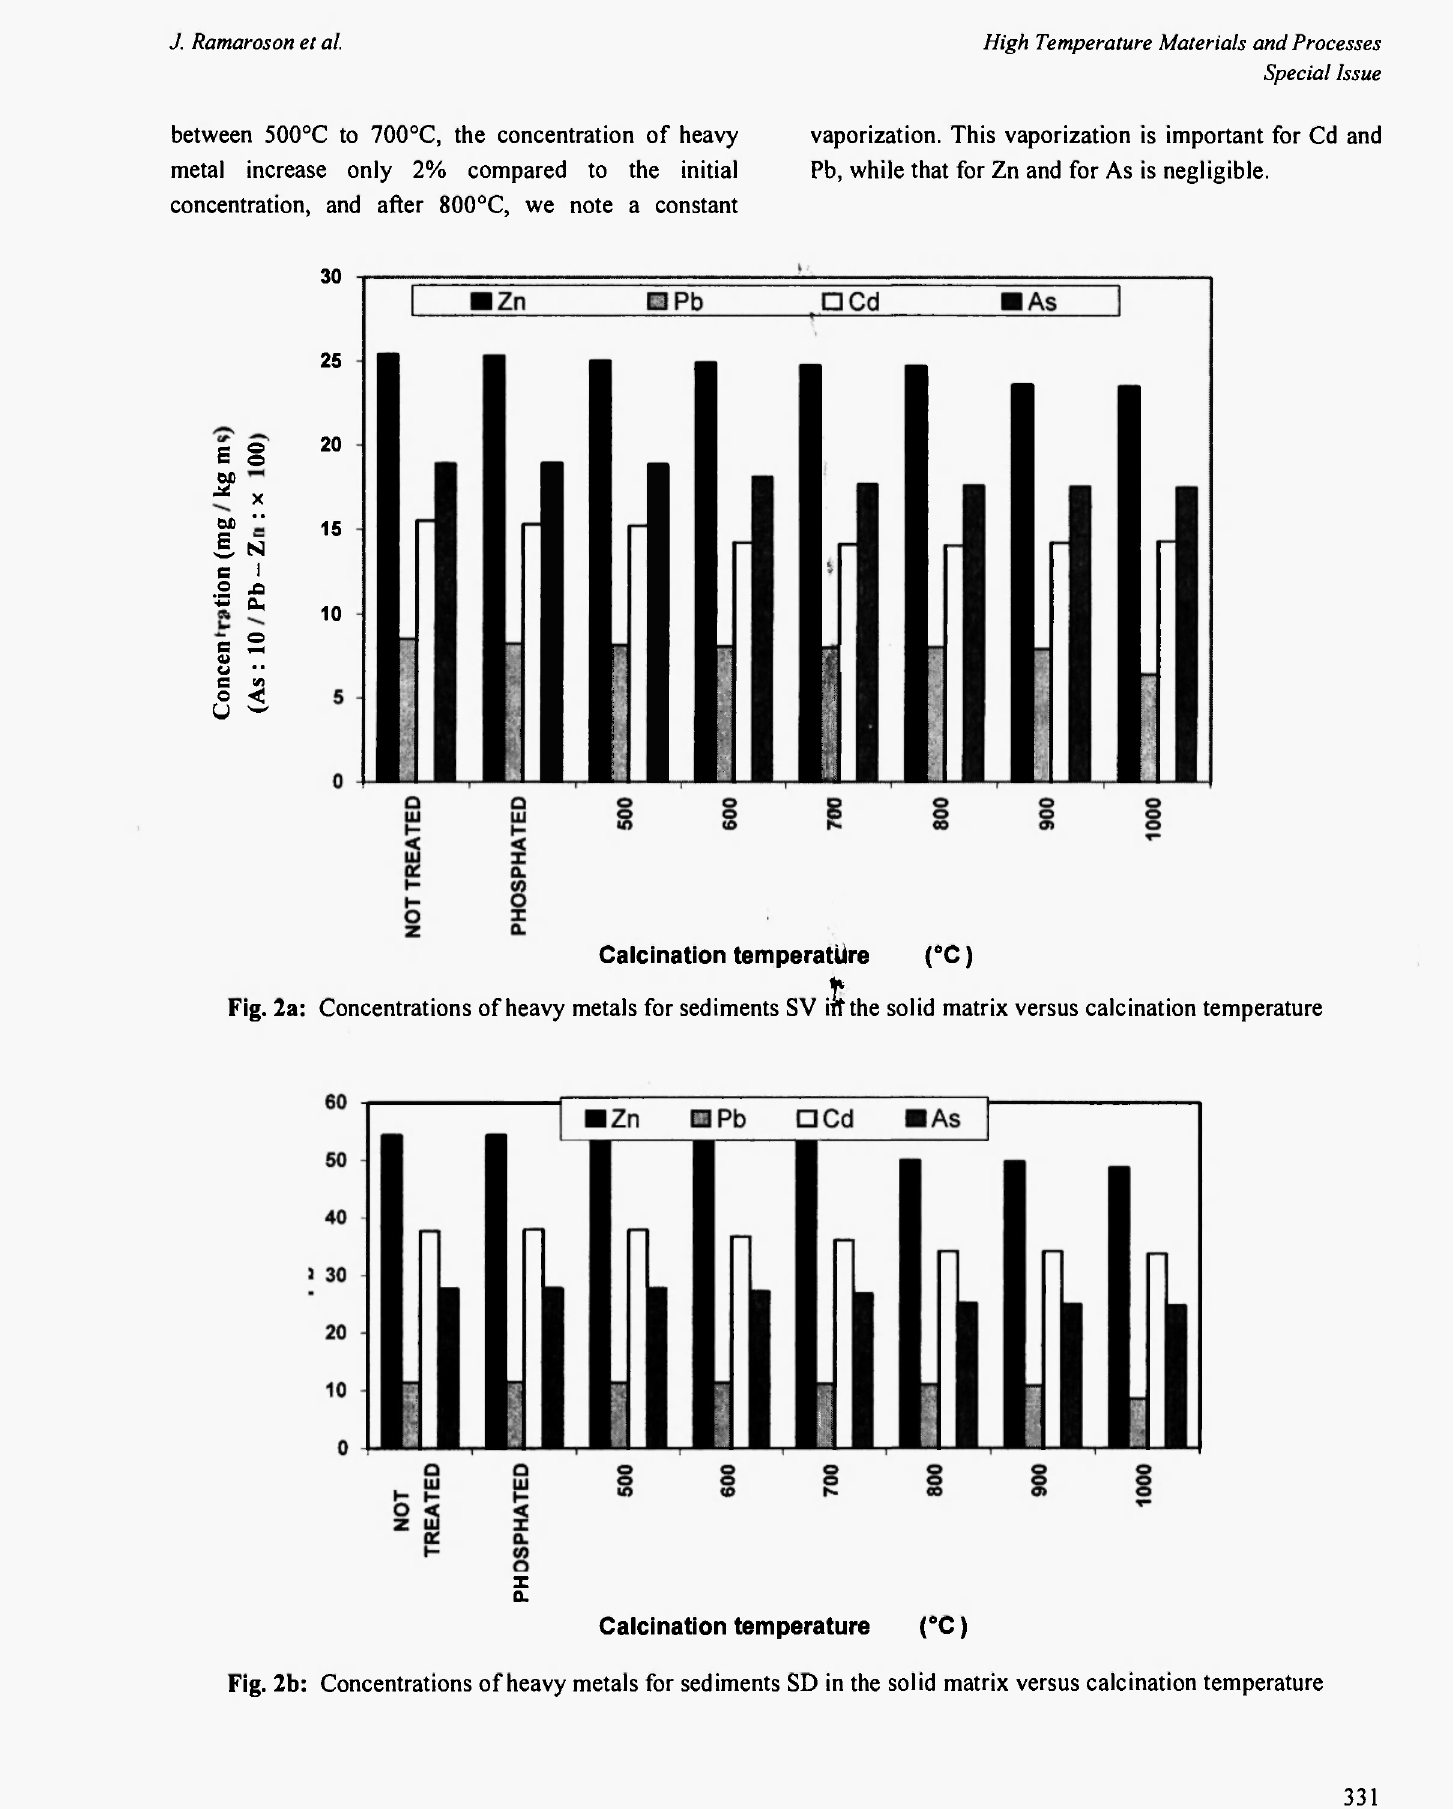
Fig. 2b: Concentrations of heavy metals for sediments SD in the solid matrix versus calcination